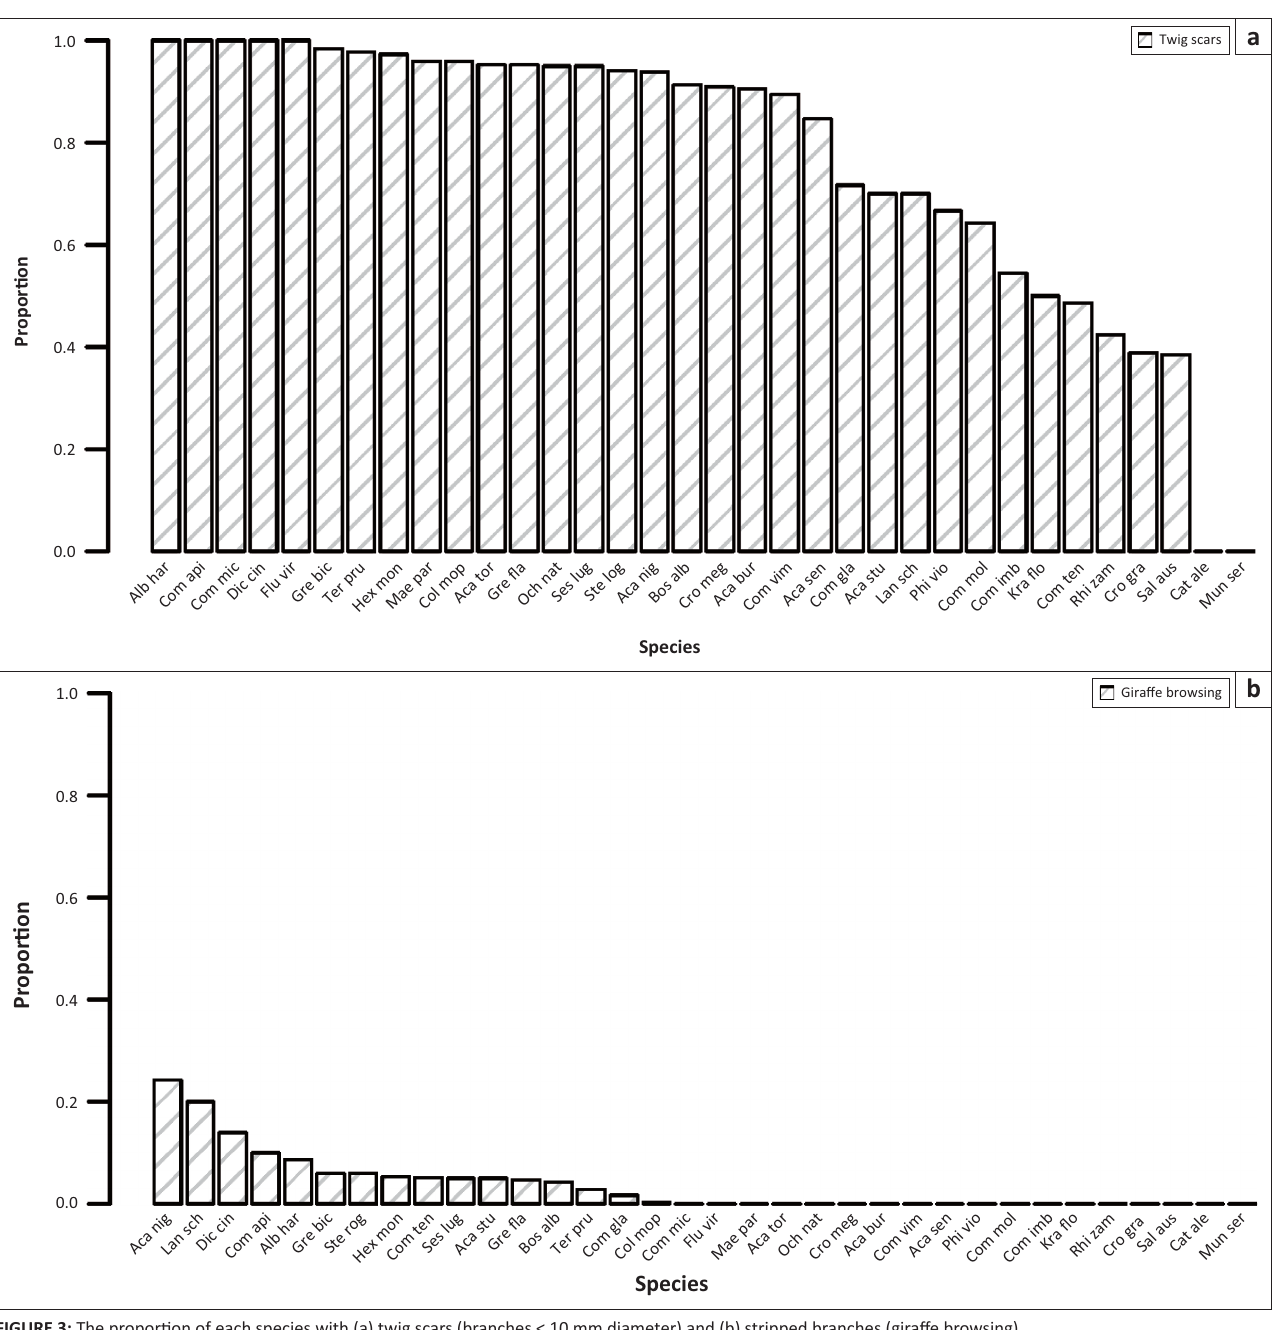
FIGURE 3: The proportion of each species with (a) twig scars (branches < 10 mm diameter) and (b) stripped branches (giraffe